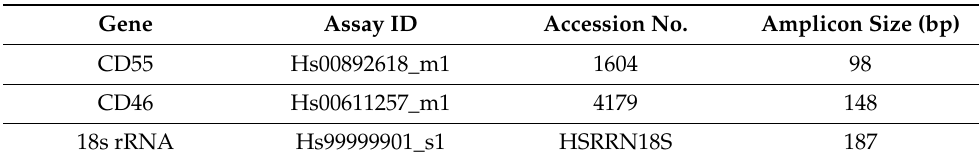
Table 1. Gene identity, NCBI accession number, and primer sequences of the primers used for the real time PCR. Gene Assay ID Accession